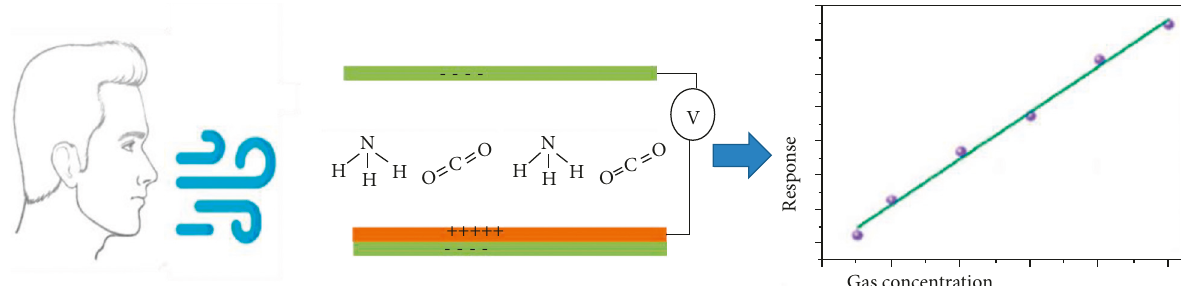
Figure 3: A schematic illustration of the respiratory exhaled gas monitoring system.